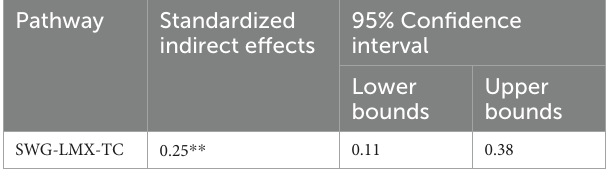
TABLE 4 Bootstrap results.